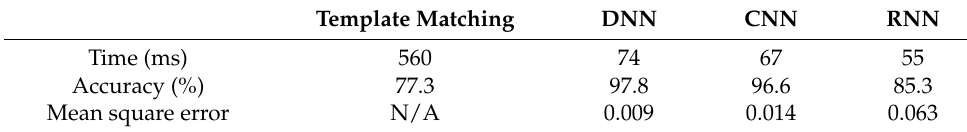
Table 3. Performances and running time (1140 waveforms) of networks and template